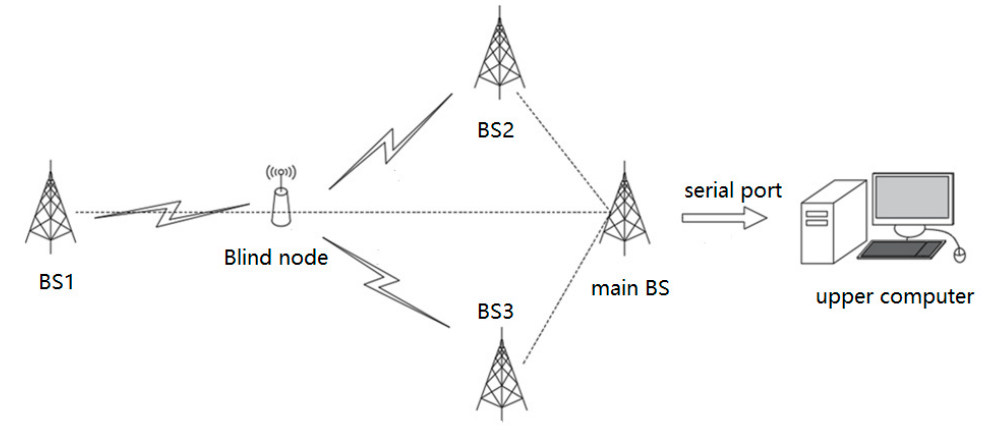
Figure 7. Components of a positioning system based on UWB signals.